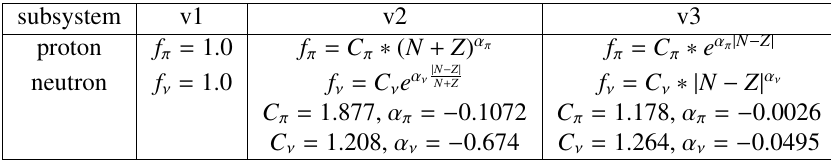
Figure 2. The spreads ∆ E B of the heights of PFBs as a function of proton and neutron numbers. ∆ E B ( Z , N ) = | E B ( Z , N ) − E B ( Z , N ) | , where, for given Z and N values, E B max min the largest and smallest heights of PFBs obtained with the employed set of four functionals. Based on Fig. 15 of Ref. [1].